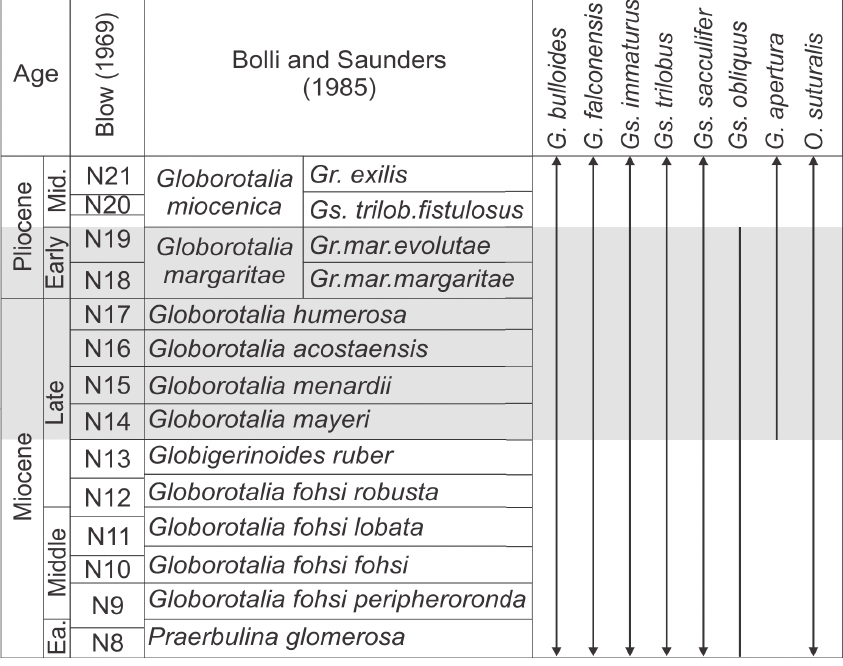
Fig. 8 - Stratigraphic ranges of selected taxa of planktonic foraminifera occurrence in the sample 140.20 m and their biocronostratigraphical signifi cance (zones and ages according to Bolli and Saunders